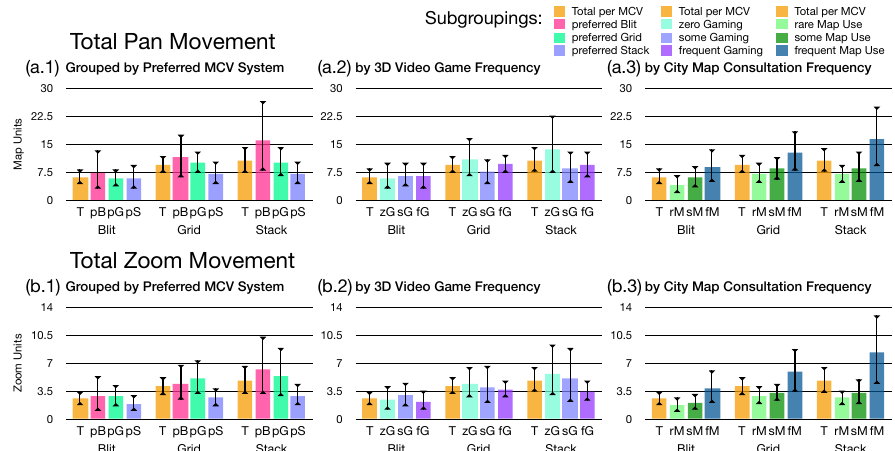
Figure 9. Map navigation measurements for each MCV system (blit/grid/stack): how much they panned the map per scenario ( a ), and how much they zoomed in/out of the map ( b ). Further subgrouped by the participants’ preference for an MCV system regarding its legibility (1), the frequency with which they play video games (2), and the frequency with which they consult city maps (3).